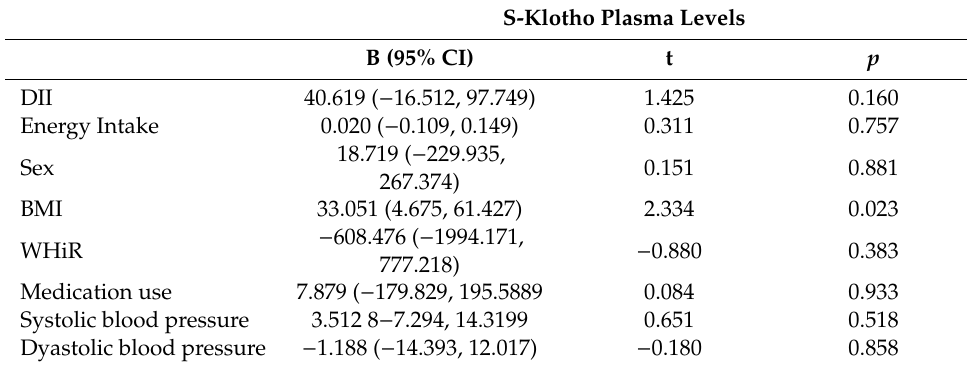
Table 2. Hierarchical regression between the dietary inflammatory index with S-Klotho plasma